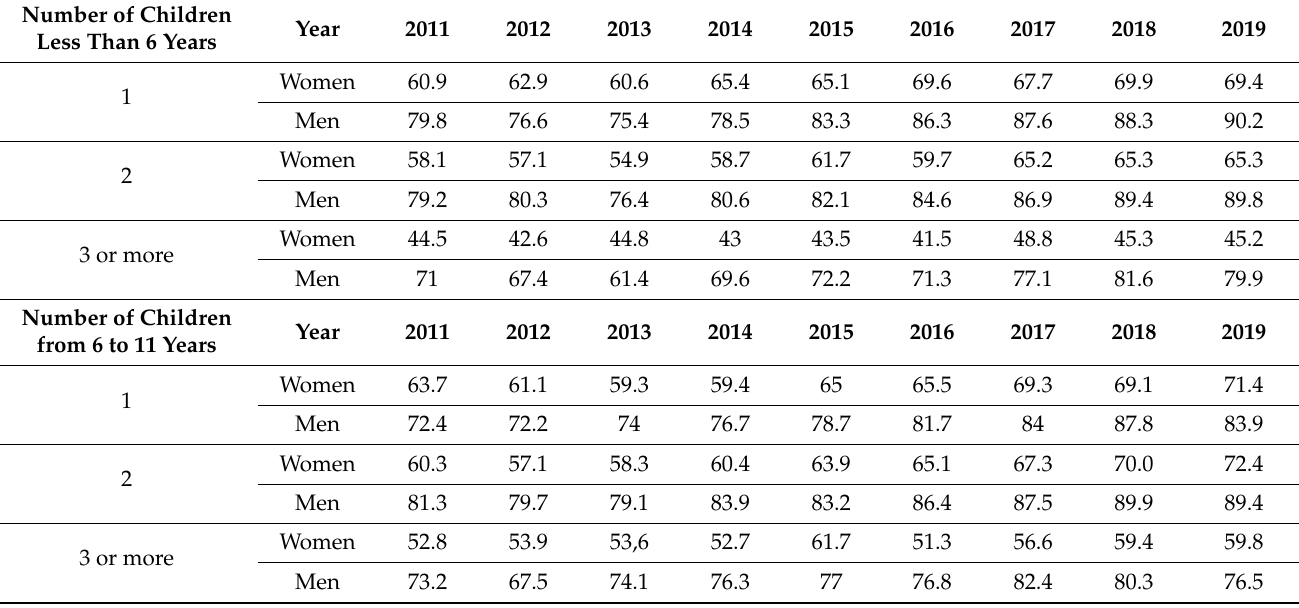
Table 11. Employment rates in Spain of adults aged 20–49 years by sex and number of children under 12 years old (in